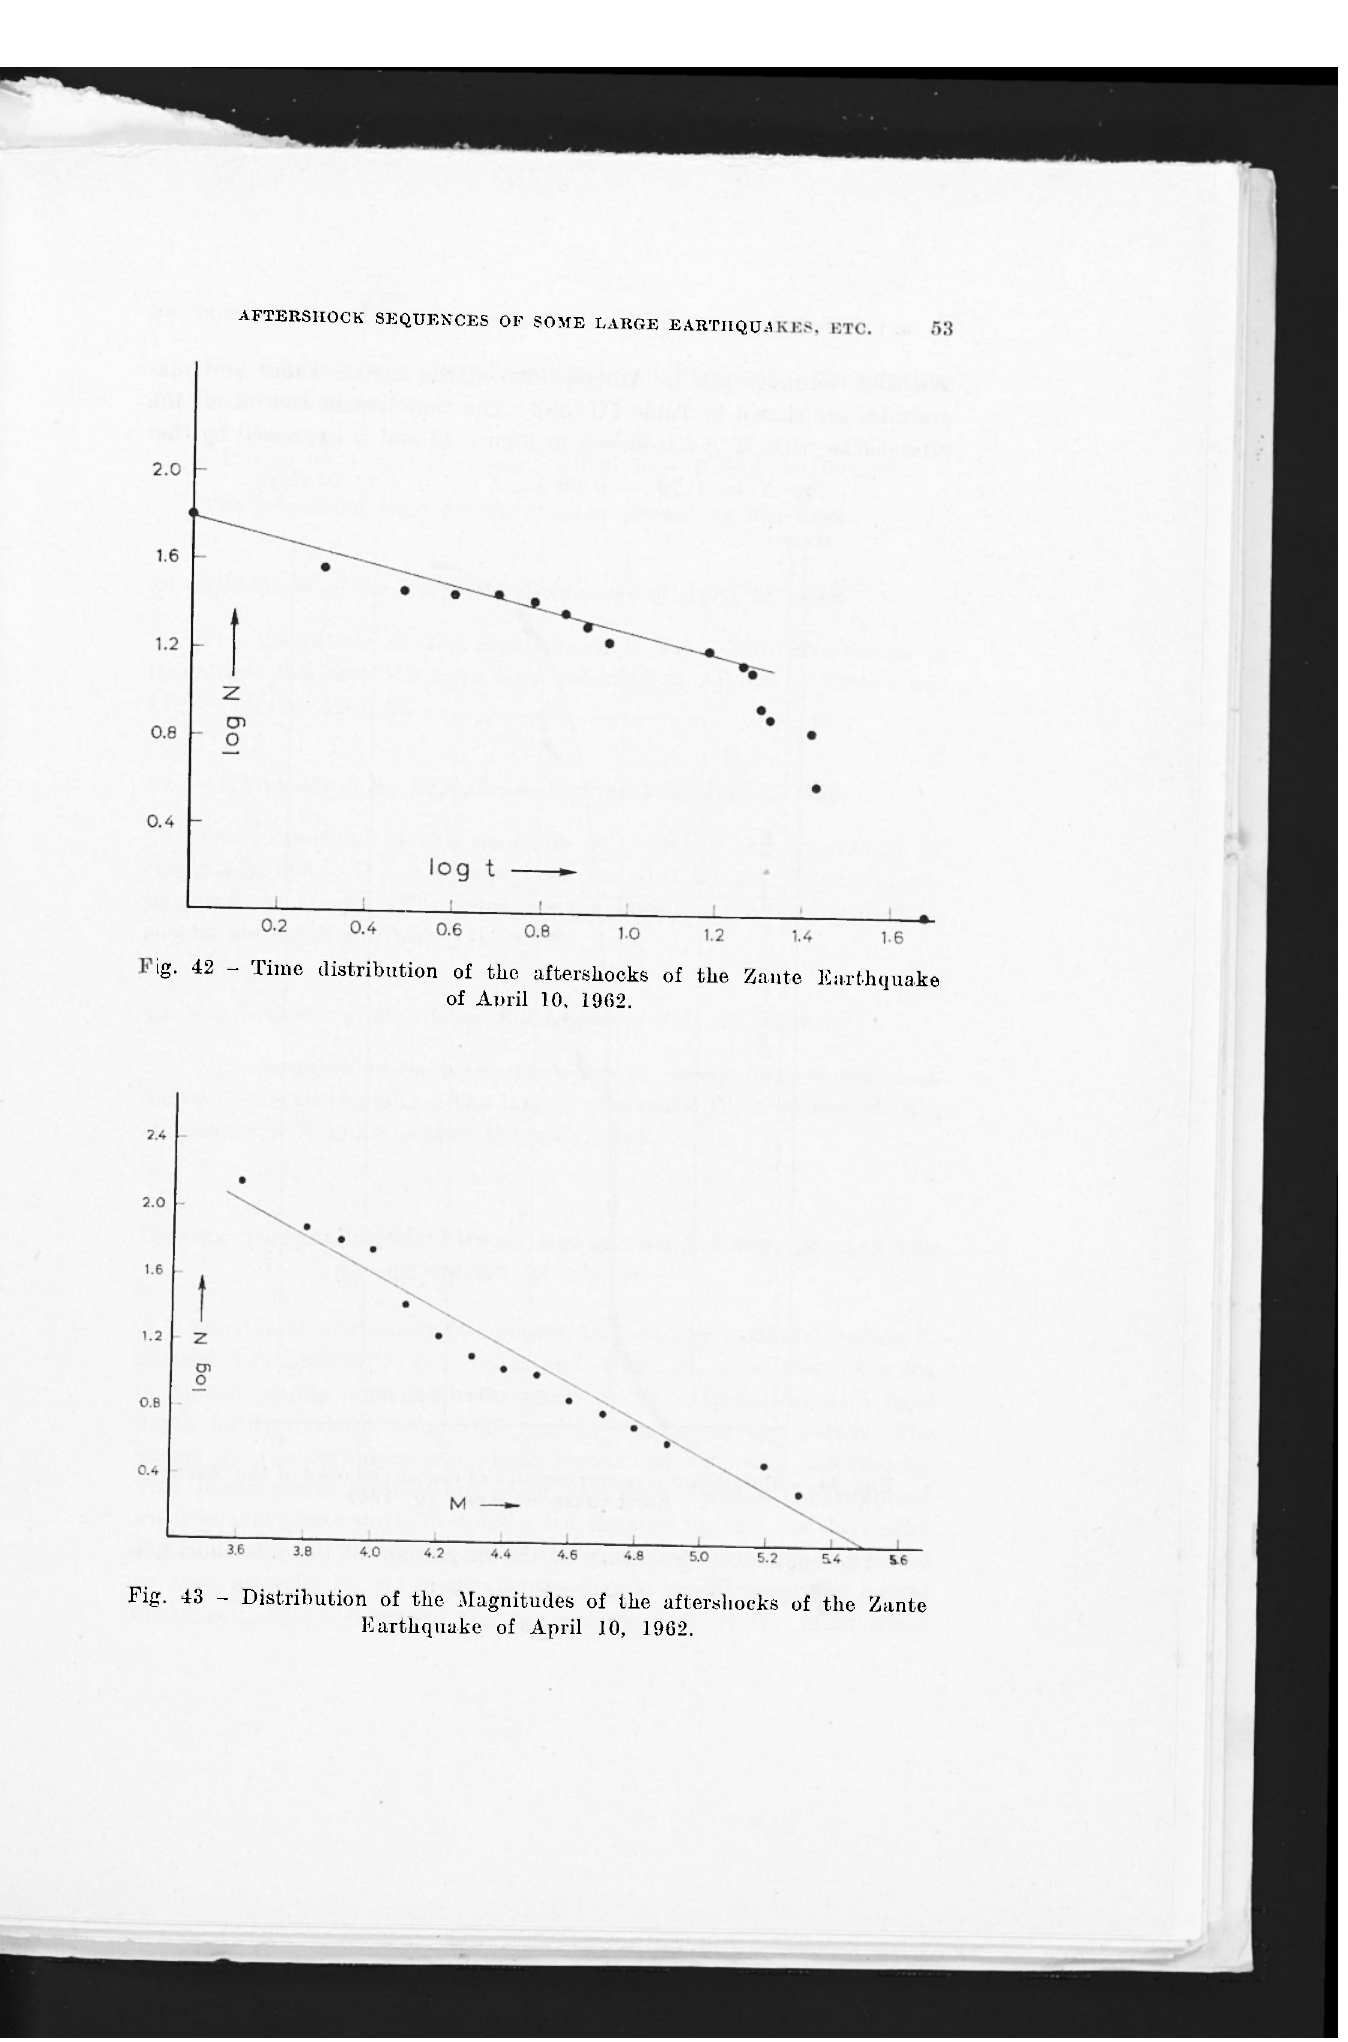
ig. 42 - Time distribution of the aftershocks of the Zante Earthquake of April 10. 1962.